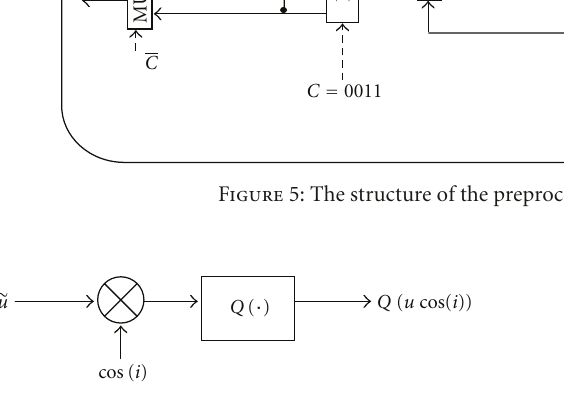
Figure 6: Truncation error model for a ROM-based